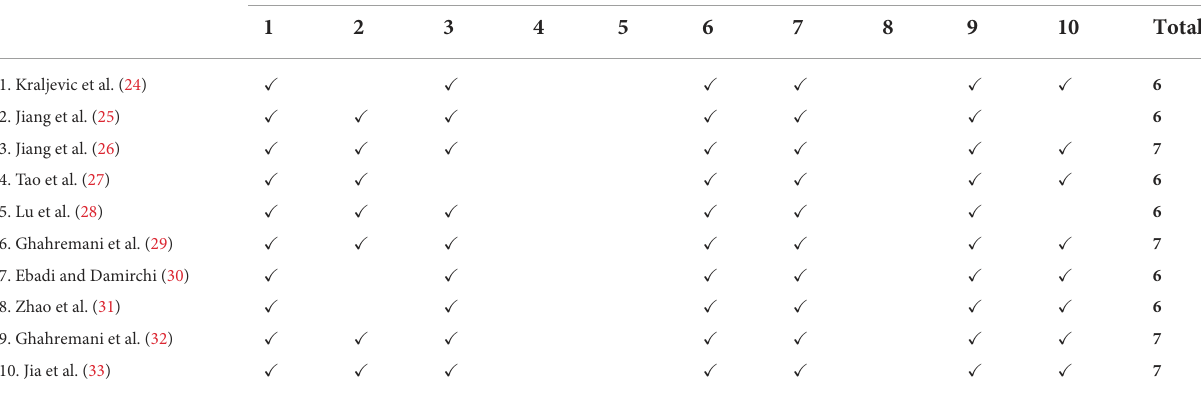
TABLE 1 The quality of included studies based on CAMARADES